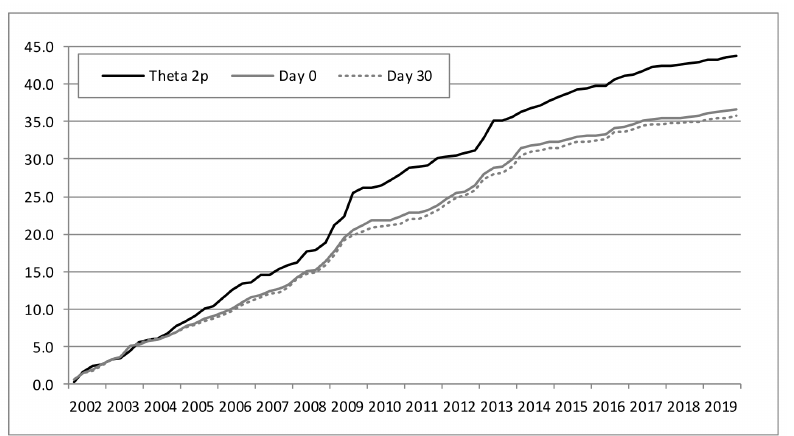
Figure 5. Cumulative absolute out-of-sample forecast error of the median of Models 1 to 6 with last- error correction given the data available at days 0 and 30 of the current quarter compared with the two-step-ahead Theta forecast (percentage points, 2002Q1–2019Q4).